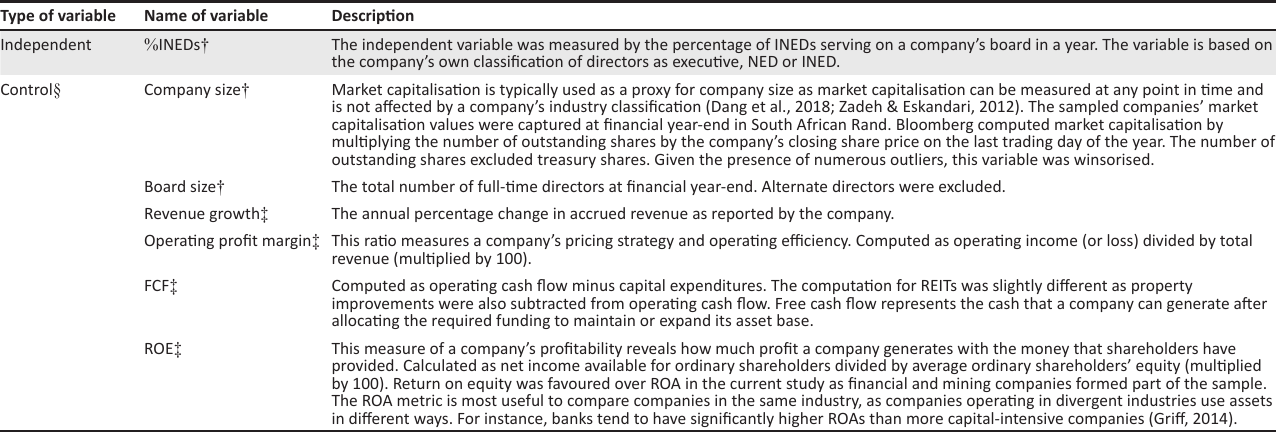
TABLE 2: Operationalisation of the independent and control variables. Type of variable Name of